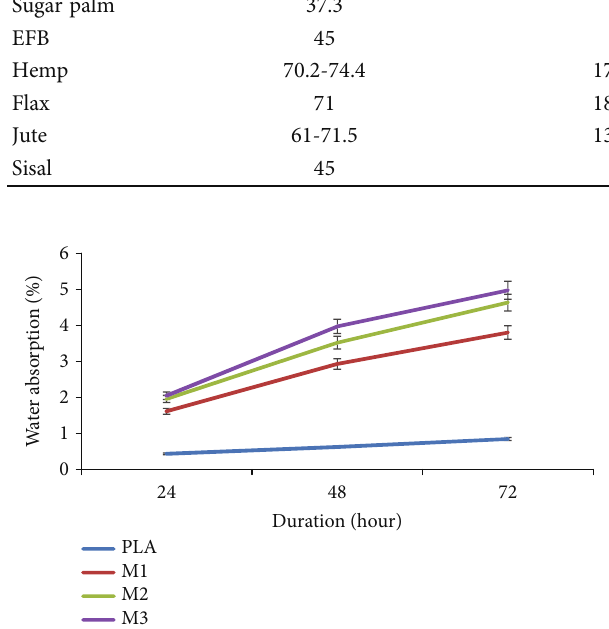
Figure 5: Water absorption level of PLA/MF